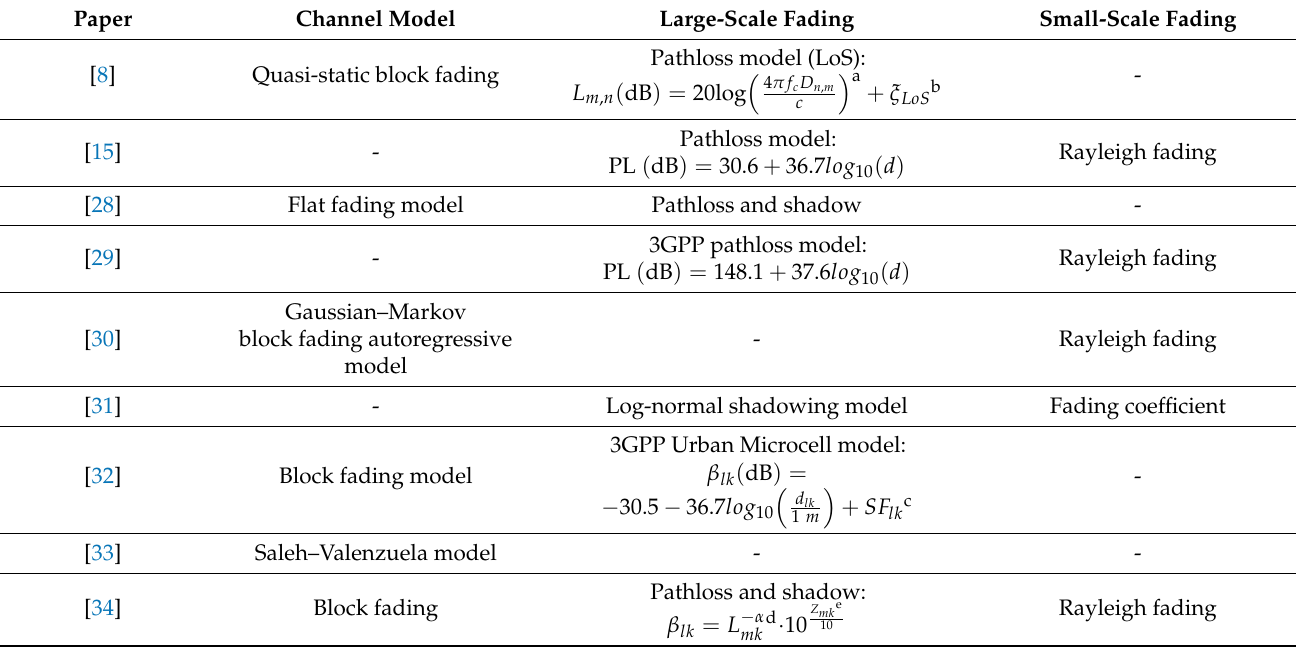
Table 1. Comparison of channel models in